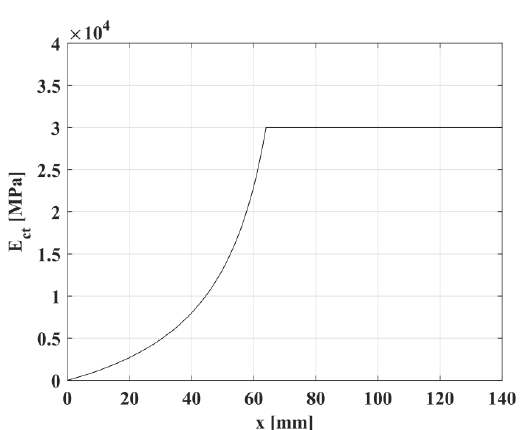
Figure 6. Trend of the elasticity modulus in tension, E ct , as a function of the crack distance assumed within this work.